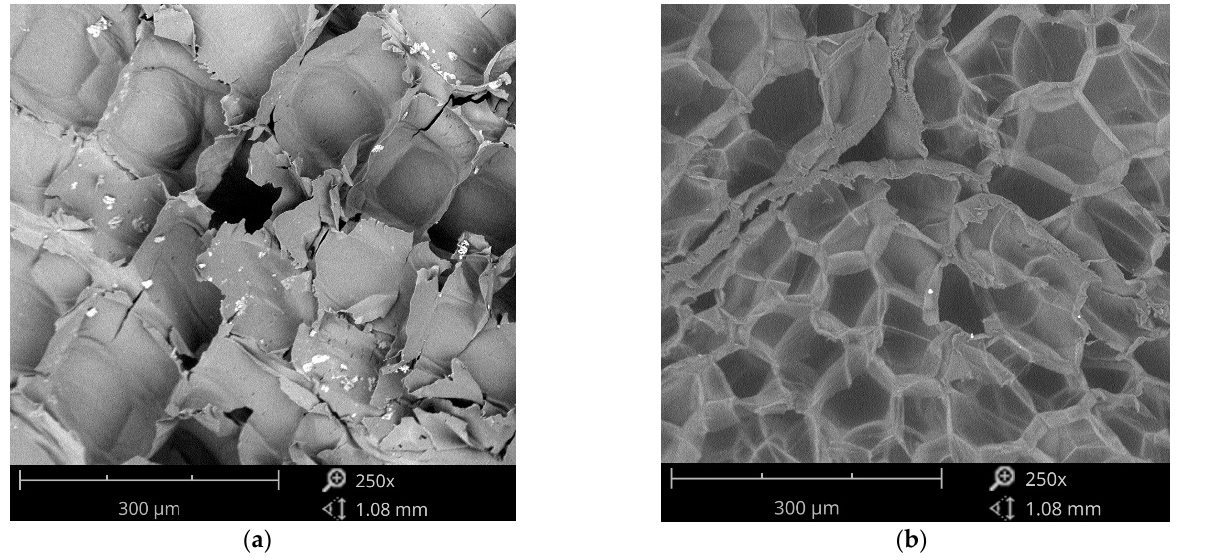
Figure 2. Structural similarities of ( a ) cup plant parenchyma, ( b ) EPS granules under scanning electron microscopy with 250× magnification [10 kV, 60 Pa, image scalebar = 300 µm].